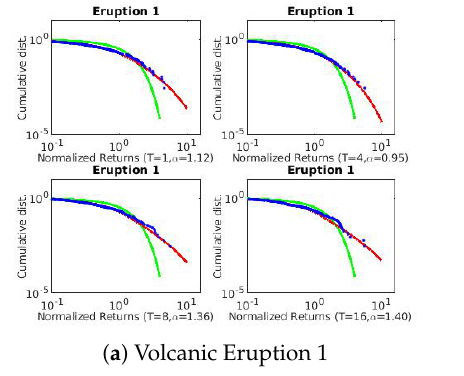
Figure A7. Lévy model fit for Volcanic Eruptions 1 and 2.